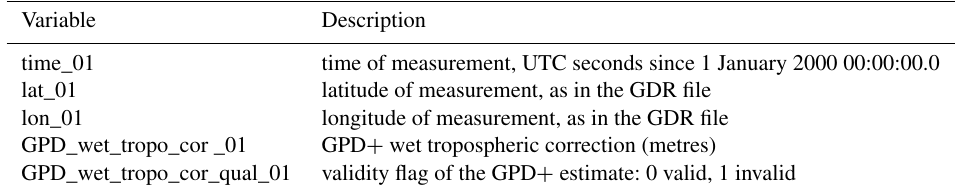
Table 3. Data content in each GPD + WTC NetCDF file, for the time and location of each RA mission measurement (Fernandes et al., 2019).